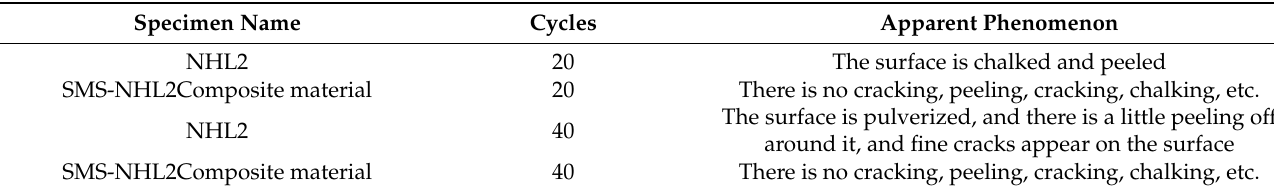
Table 9. Apparent phenomena of dry and wet cycle test.